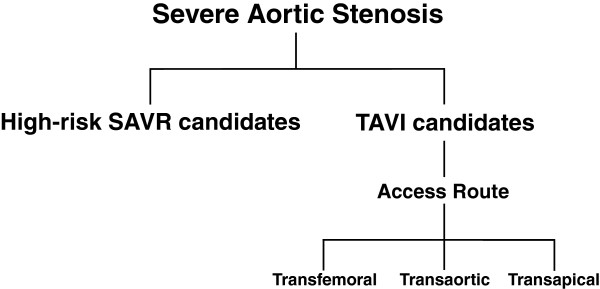
SANITY study design.